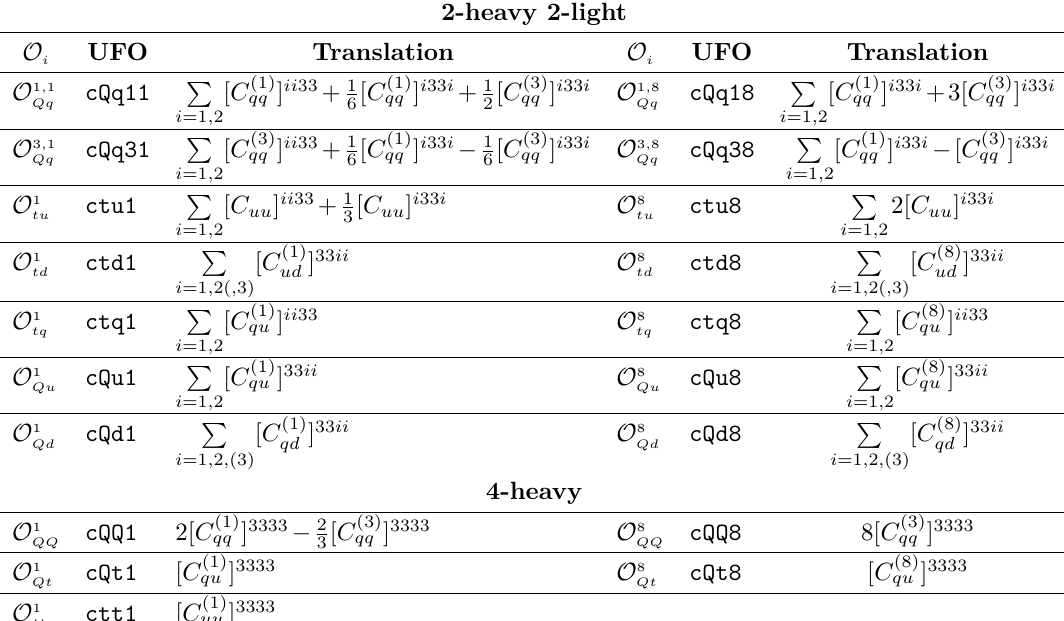
Table 5 . The translation of four-fermion operators from the Warsaw basis to the top-basis. The UFO column shows the notation of the corresponding WCs in the SMEFTatNLO